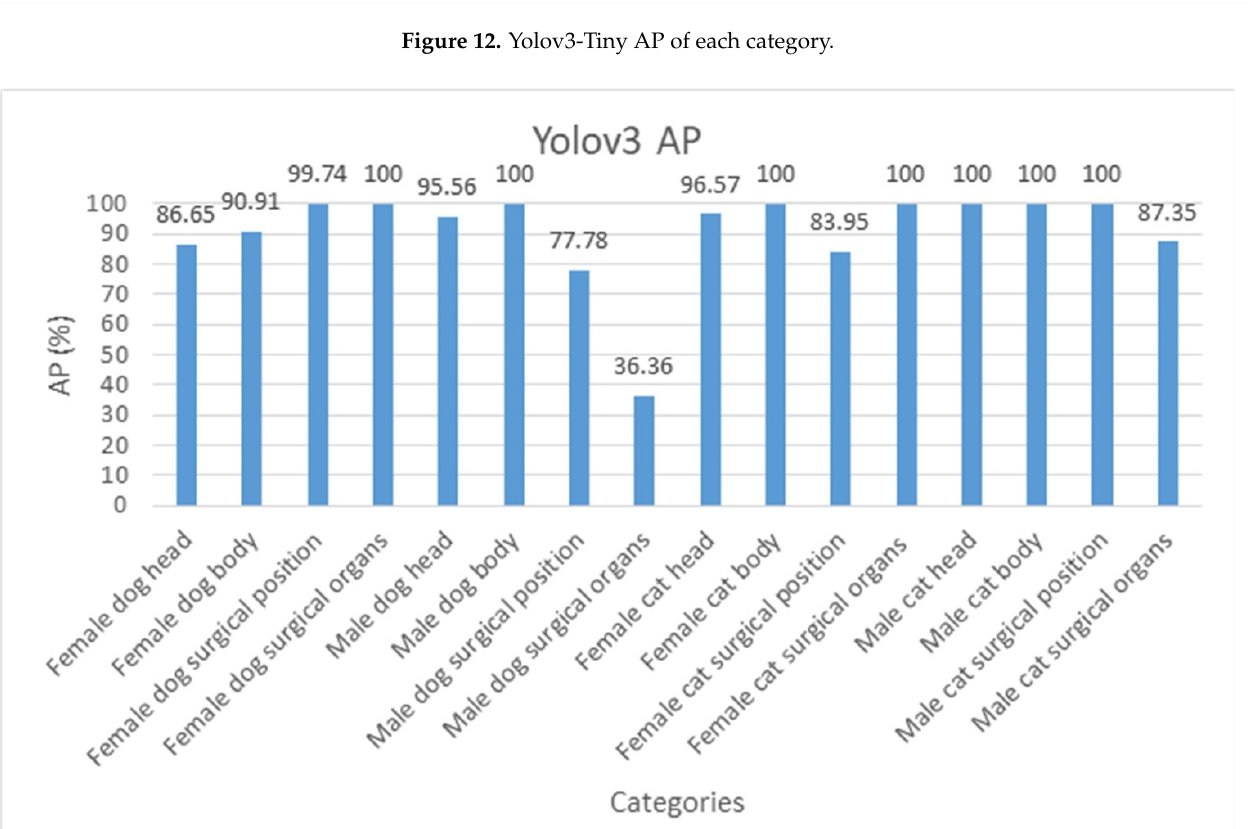
Figure 14. Yolov4 AP of each category.